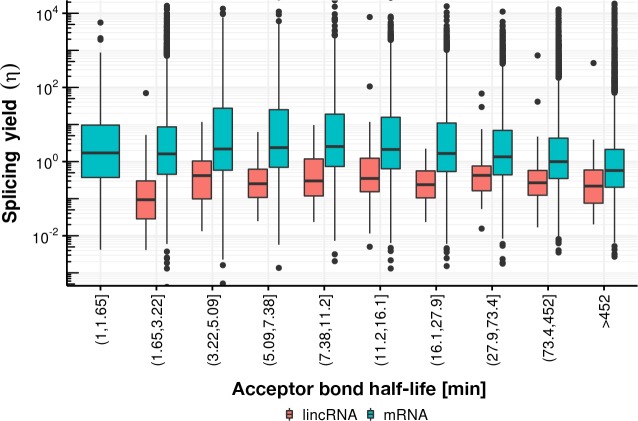
Splicing yield distribution (boxplot) of lincRNA (red) and mRNA (blue) stratified by bins of acceptor bond half-life.Although yield correlates negatively with acceptor bond half-life (for half-life larger than 16 min), indicative of potential estimation bias, the mRNA yield remains higher than the lincRNA yield in every stratum.